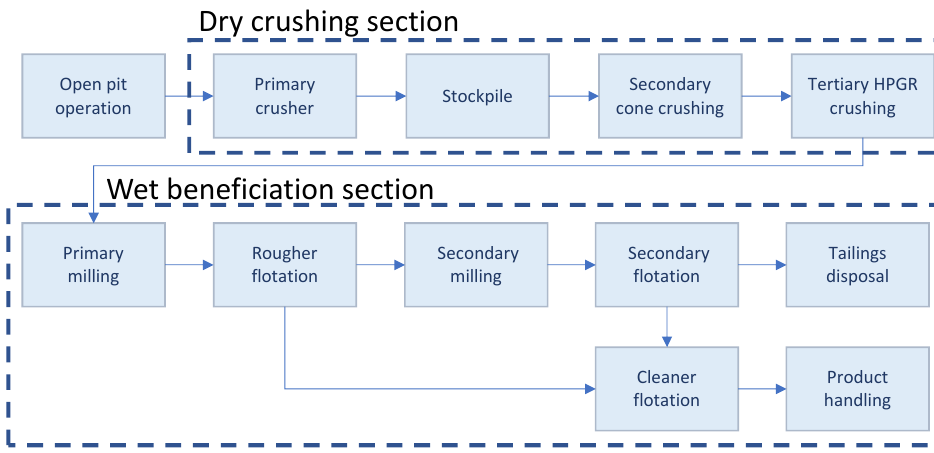
Figure 1. A high-level process flow diagram of the platinum concentrator